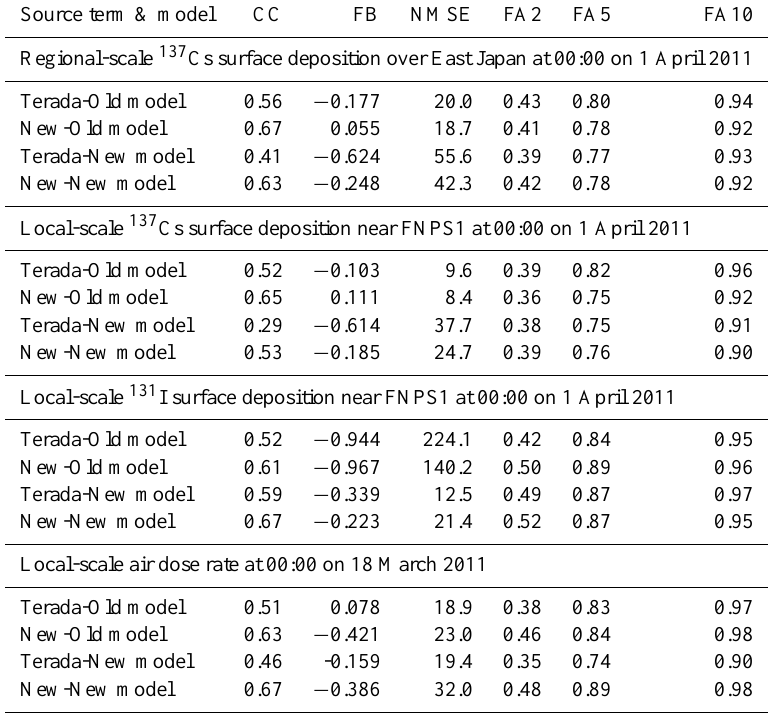
Table 7. Statistics of the surface depositions of total 131 I and 137 Cs, and air dose rate between observations and calculations using any combinations of original and modified WSPEEDI-II (referred as “Old model” and “New model”, respectively) and Terada at al. (2012) and the new source terms (referred as “Terada” and “New”, respectively). Six statistical parameters were selected to represent different evaluation metrics: the correlation coefficient (CC), the fractional bias (FB), the normalized mean square error (NMSE), and the percent within a factor of two, five, and ten (FA2, FA5, FA10). Regional- and local-scale data were compared with calculations of WSPEEDI-II over domain 2 and 3,